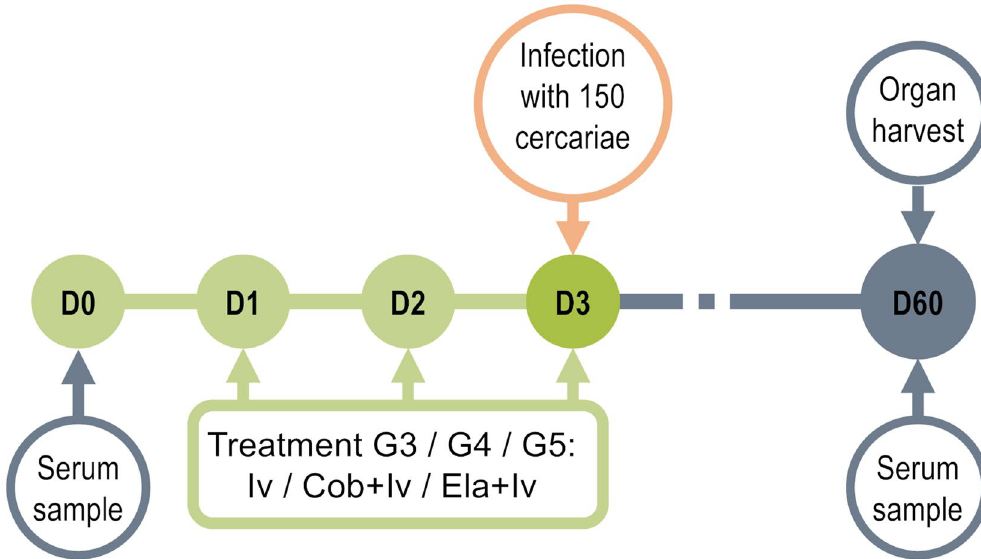
Figure 1. Study timeline. Ivermectin or ivermectin and cobicistat or ivermectin and elacridar were administered daily for three days before infecting BALB/c mice with 150 cercariae of S. mansoni . After 8 weeks of infection, parasite load in organs and IgG production against SoSmAWA antigen were examined. Treatment tolerance was monitored